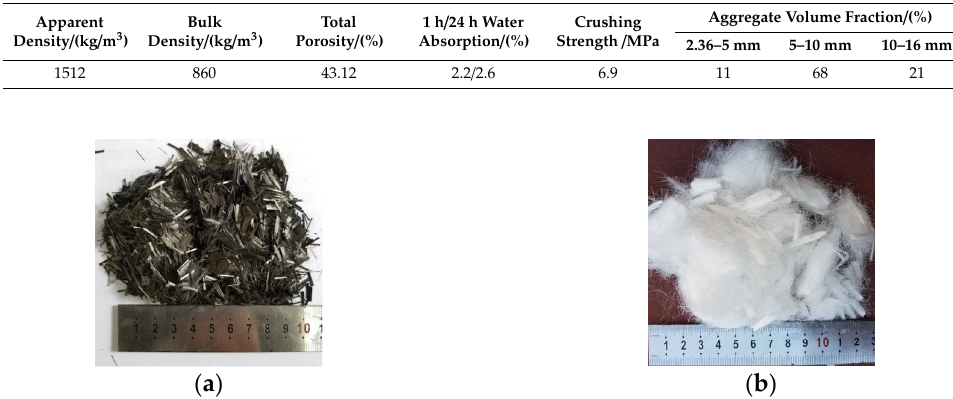
Figure 1. Angular expanded shale ceramist. Table 3. Properties and grading of LWA.